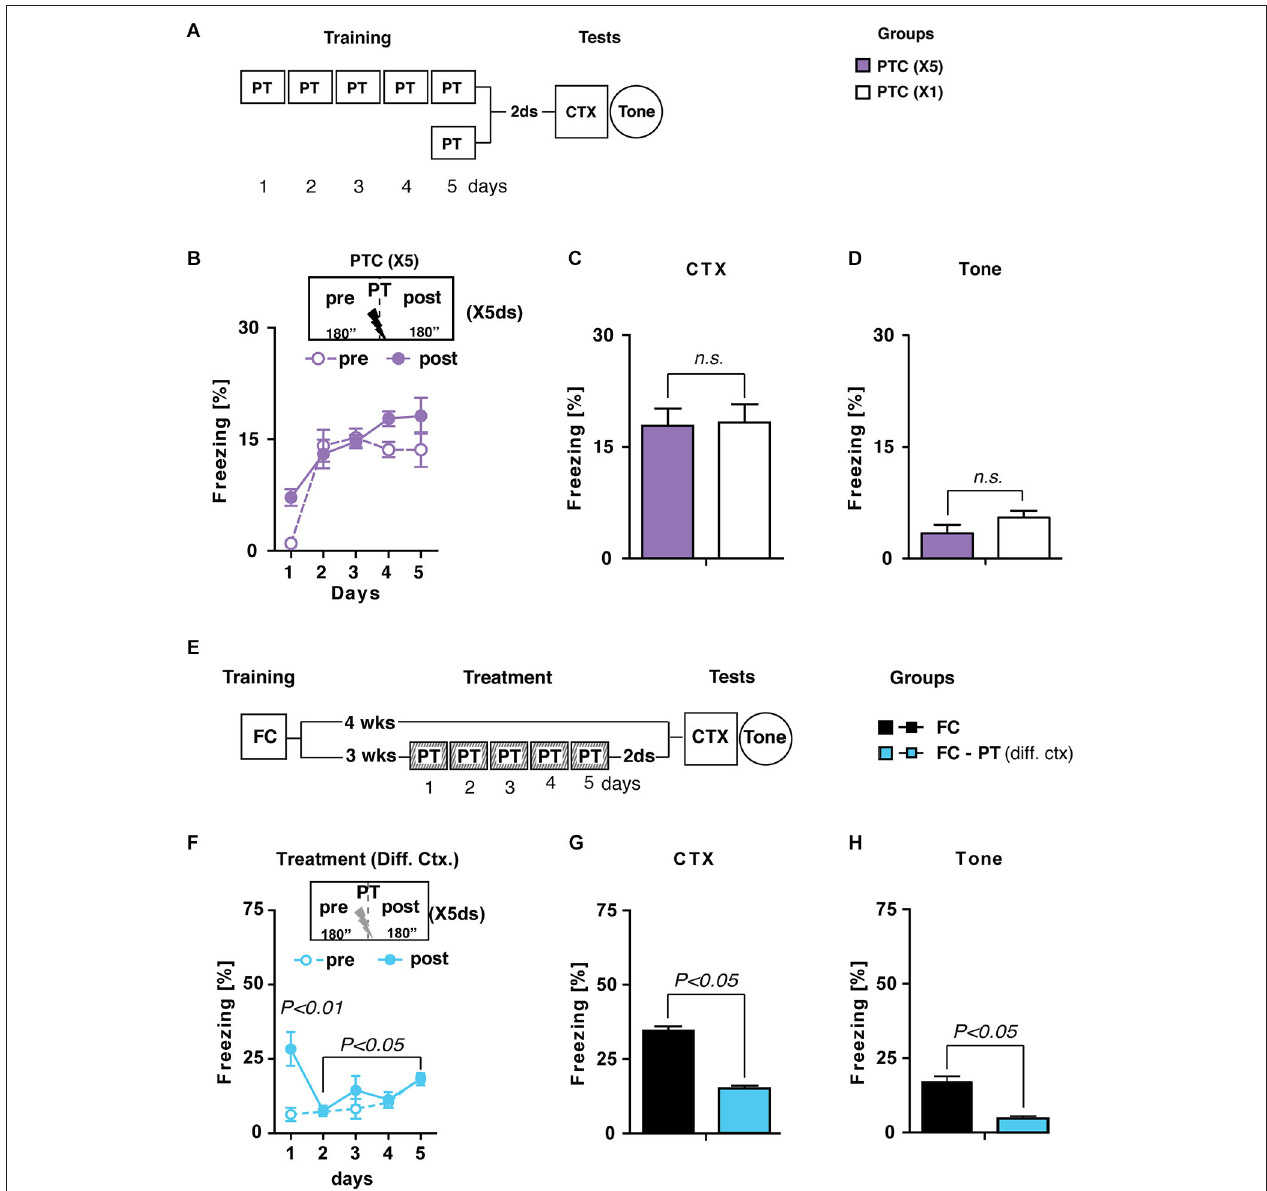
fear-conditioned mice ( n = 8) submitted to contextual memory test (CTX) and fear sensitization (Tone) 4 weeks after training. FC-PT (diff. ctx) , fear-conditioned mice ( n = 8) treated with the PT administration in a different context 3 weeks after training and then submitted to CTX and Tone. ( F ) Freezing (%) during PT treatment in a different context (FC-PT (diff. ctx) ) was plotted as a mean of the 180” before (pre) and after (post) the PT administration for each daily trial. ( G–H ) Freezing (%) in the ( G ) CTX and ( H ) in response to a neutral tone (Tone) recorded in FC and FC-PT (diff. ctx) . The results indicate that PT treatment carried out in a different context was able to reduce both contextual fear memory and fear sensitization. Data are expressed as mean + SEM. Results of individual post hoc comparisons (Duncan’s and Fisher’s tests) are depicted in the figure [n.s., not significant = P >